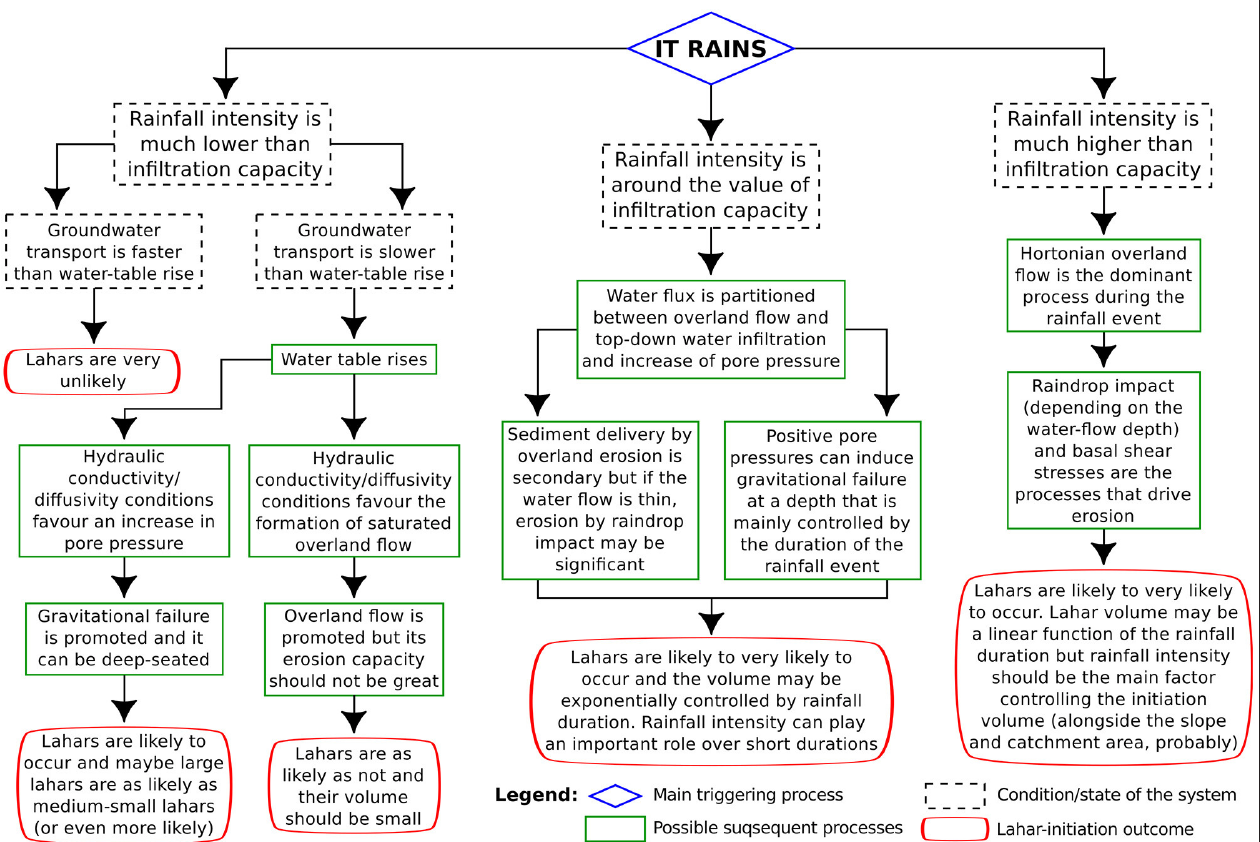
FIGURE 3 | Schematic of the reasoning about the physical processes associated with the triggering of lahars by means of rainfall utilized to construct our BBN model: Multihaz (see Figure 2 and Table 1 ). Together with Table 2 , this reasoning defines the structure and parameterization of Multihaz (see text for more details).